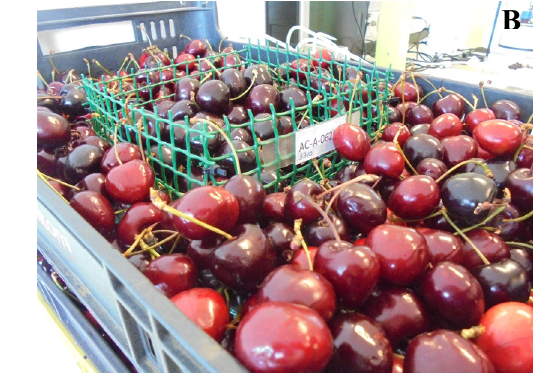
Figure 1. Sweet cherries cv. Satin numbering ( A ) and netted basket with the numbered sweet cherries placed in the centre of a 5 kg commercial tray ( B ).